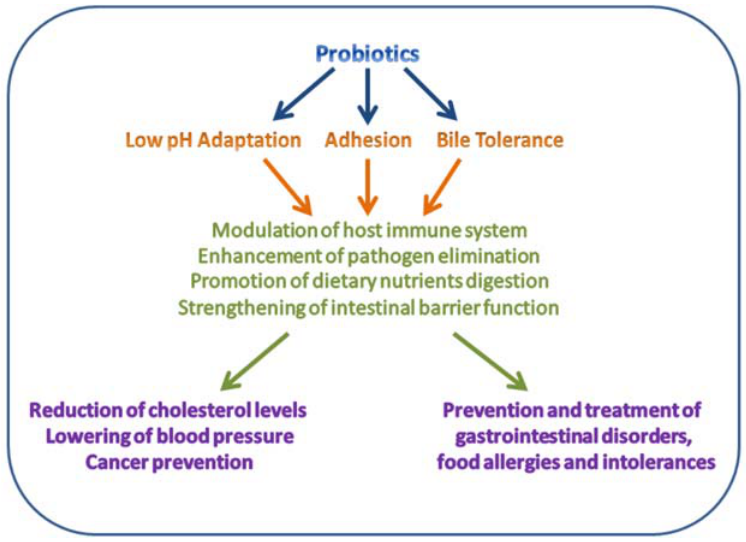
Figure 2. Some beneficial effects of probiotics to human health. Modified from Reference [29].